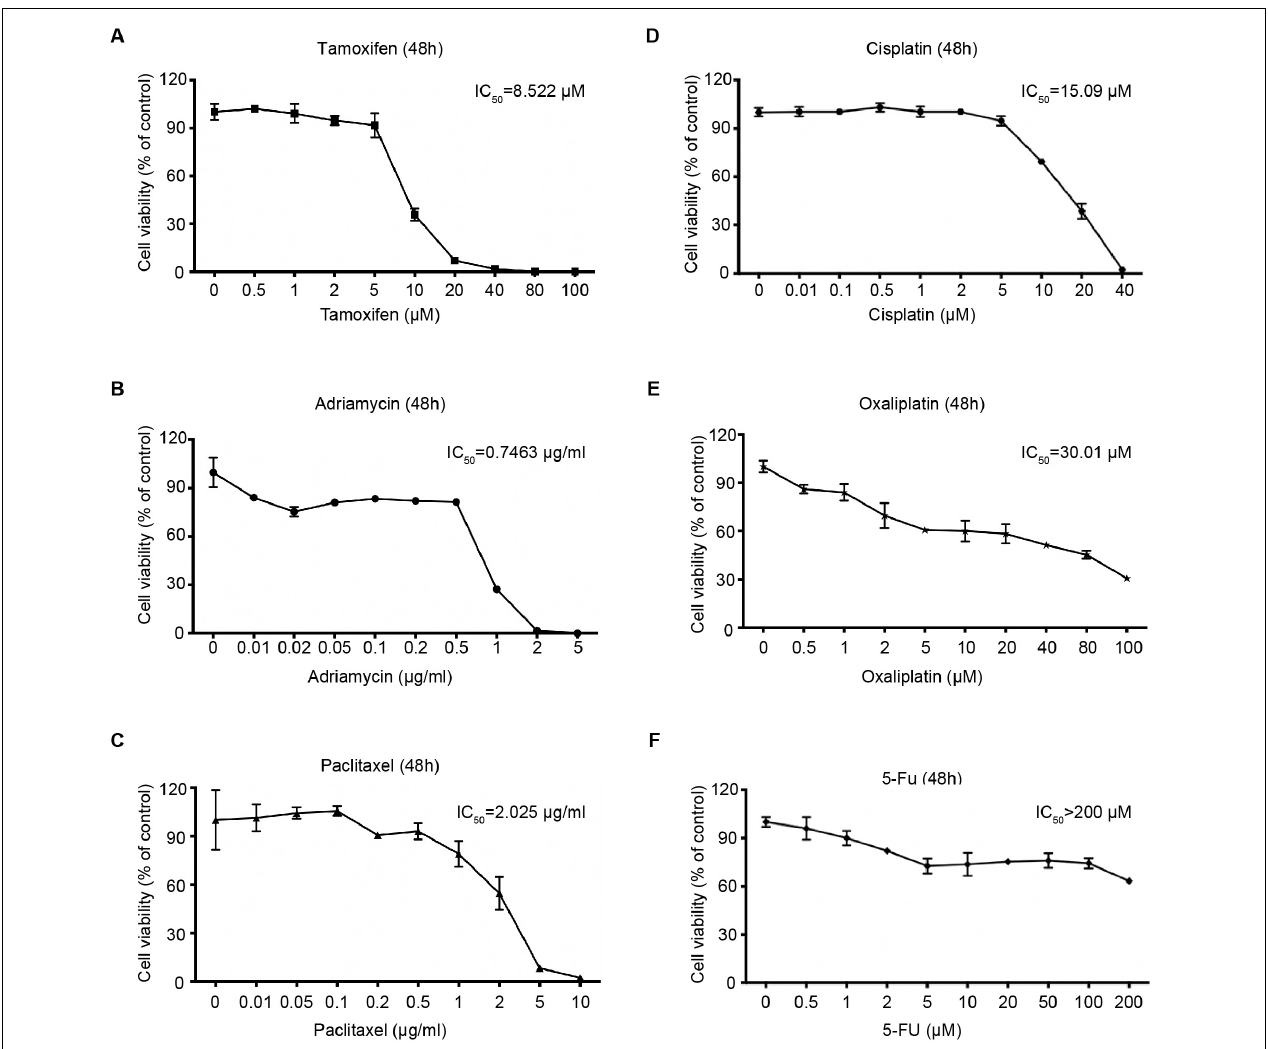
FIGURE 5 | Sensitivity of the 4Z-B-1 cell line to other anticancer agents. (A–F) Sensitivity of 4Z-B-1 cells to tamoxifen, adriamycin, paclitaxel, cisplatin, and oxaliplatin and